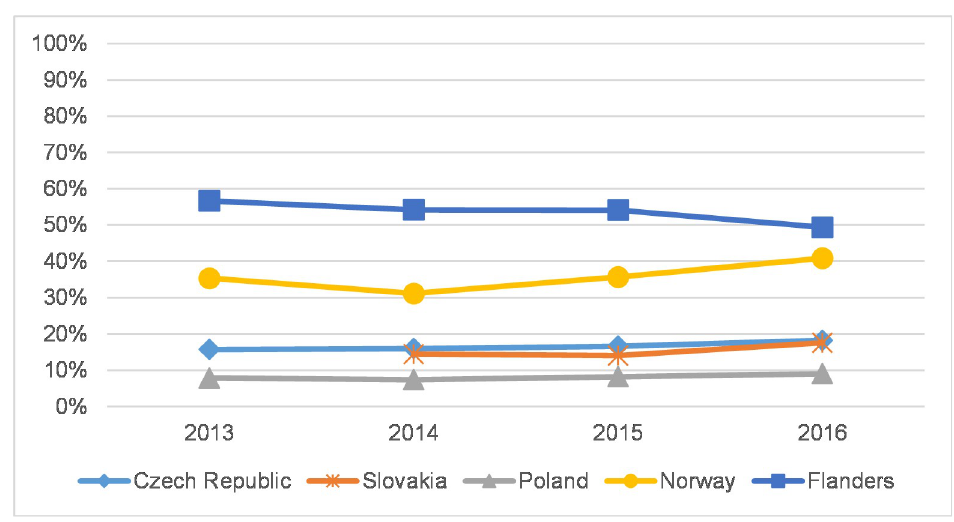
Fig 4. Coverage of journal articles in WoS–humanities.